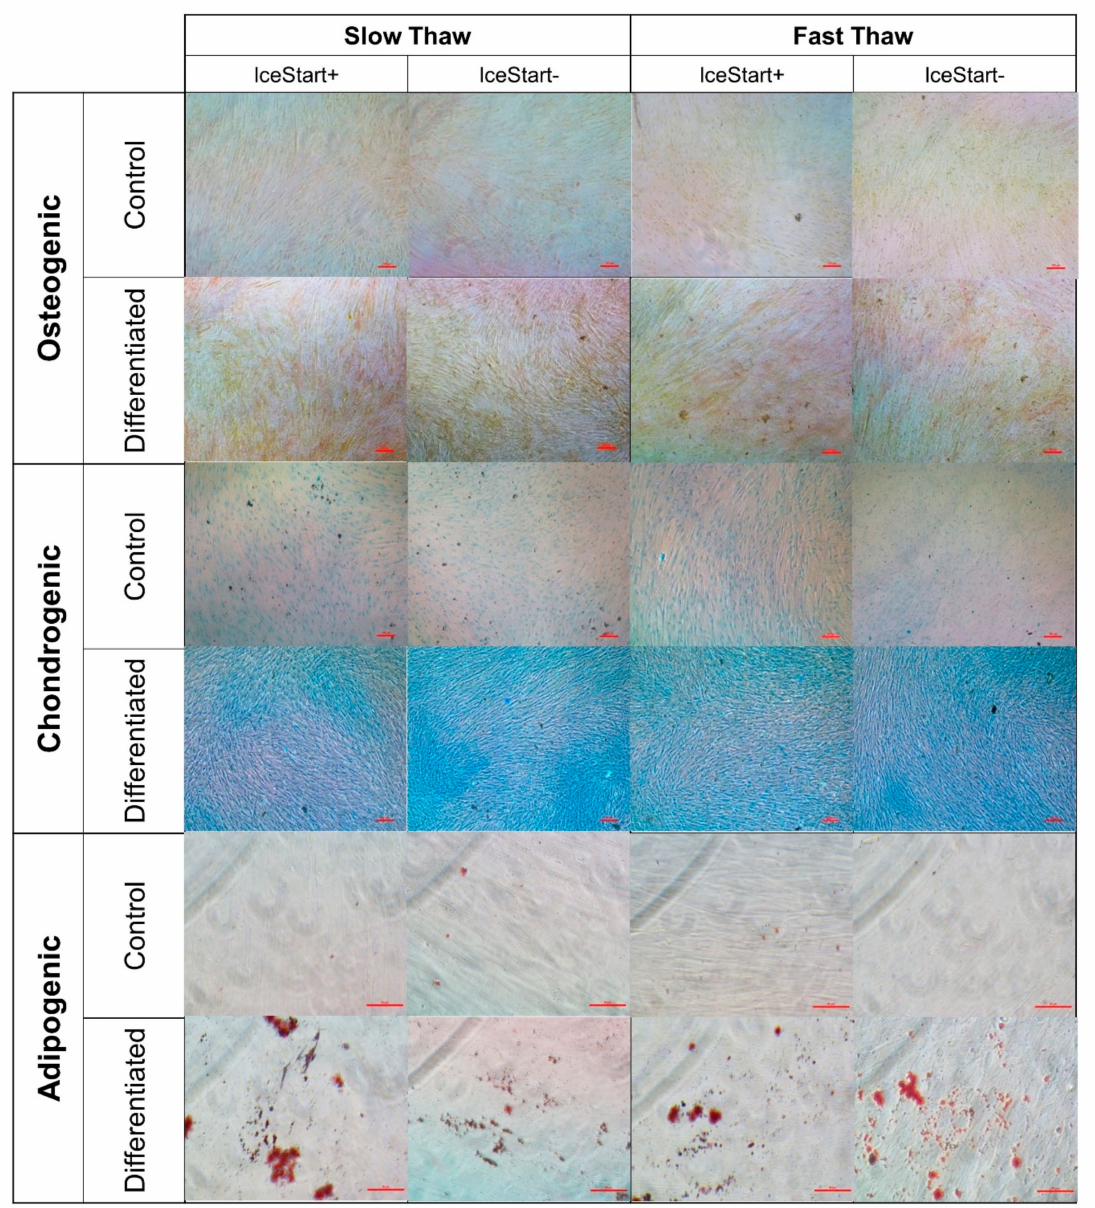
Figure 6. Representative images of MSC tri-lineage differentiation. No inhibition of differentiation was observed in any condition (3 donors). Control is stain control (without culture in differentiation medium). Osteogenic and chondrogenic conditions scale bar: 100 µ m, Adipogenic conditions scale: 50 µ